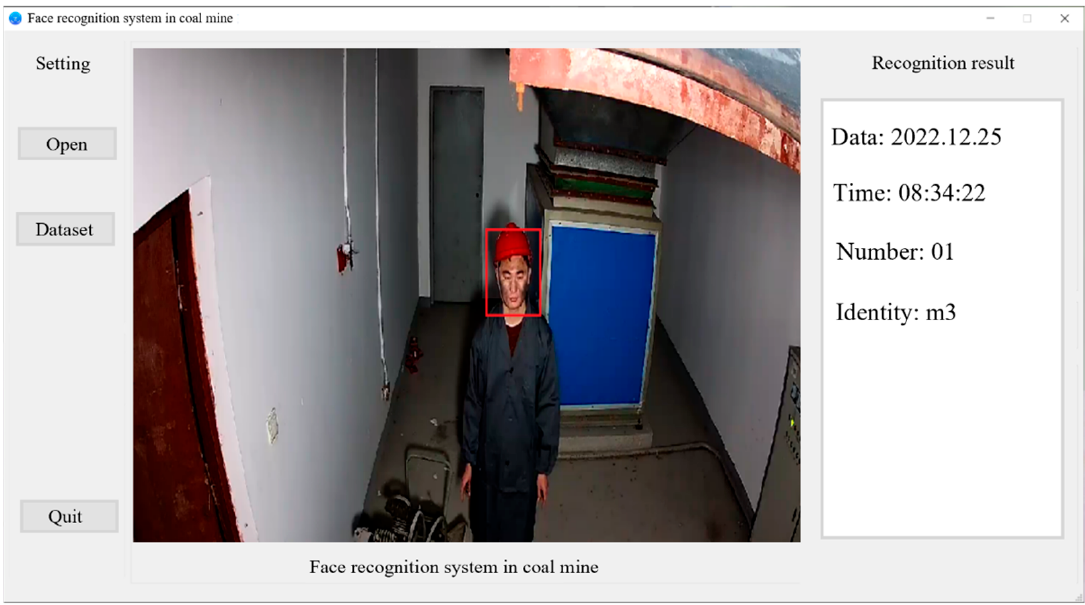
Figure 17. Experimental scene test.